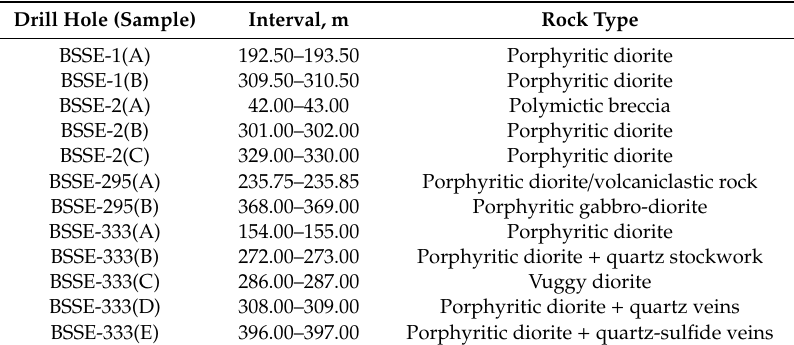
Table 1. List of the 12 drill core drill samples examined in this